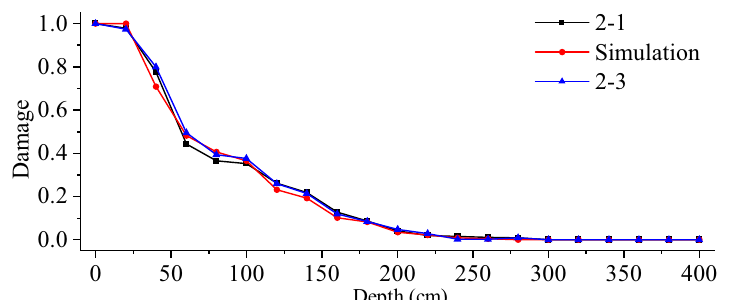
Figure 11. Comparison of field test and numerical simulation